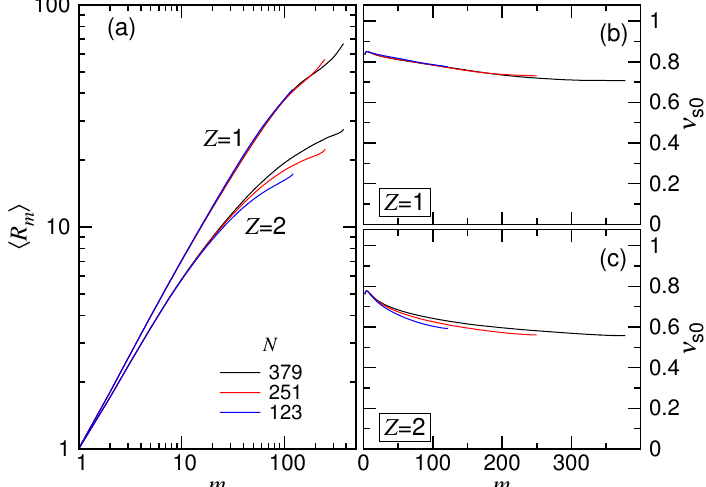
Figure 12. ( a ) Mean distance (cid:104) R m (cid:105) of a monomer to the tethering point on a tethered chain of length N = 123, 251 and 379 in the Z = 1 and Z = 2 salt solutions. Here, m is the monomer index. The calculated exponent ν s0 is plotted against m in ( b ) the monovalent and ( c ) the divalent salt